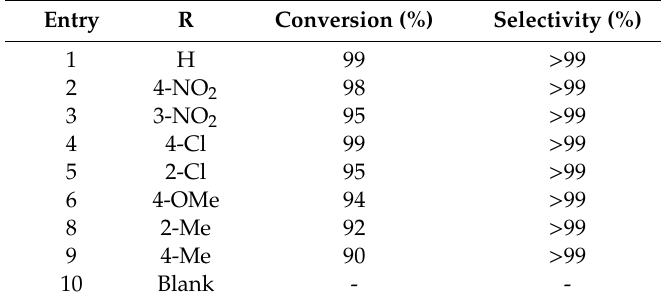
Table 1. Knoevenagel condensation reaction of various aldehydes with malonitrile catalyzed by the periodic mesoporous organosilica (PMO)-Py catalyst.